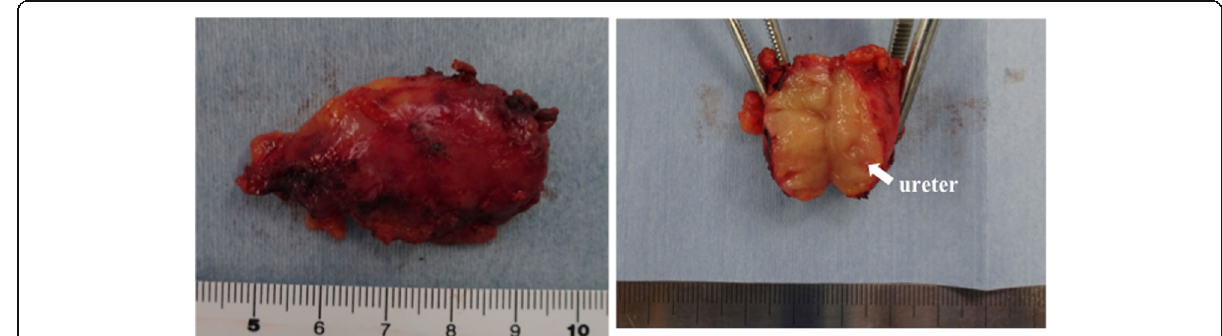
Fig. 4 Macroscopic findings of the resected specimen. An elastic and soft mass similar to a swollen lymph node with a lumen structure (ureter) was detected (arrow)